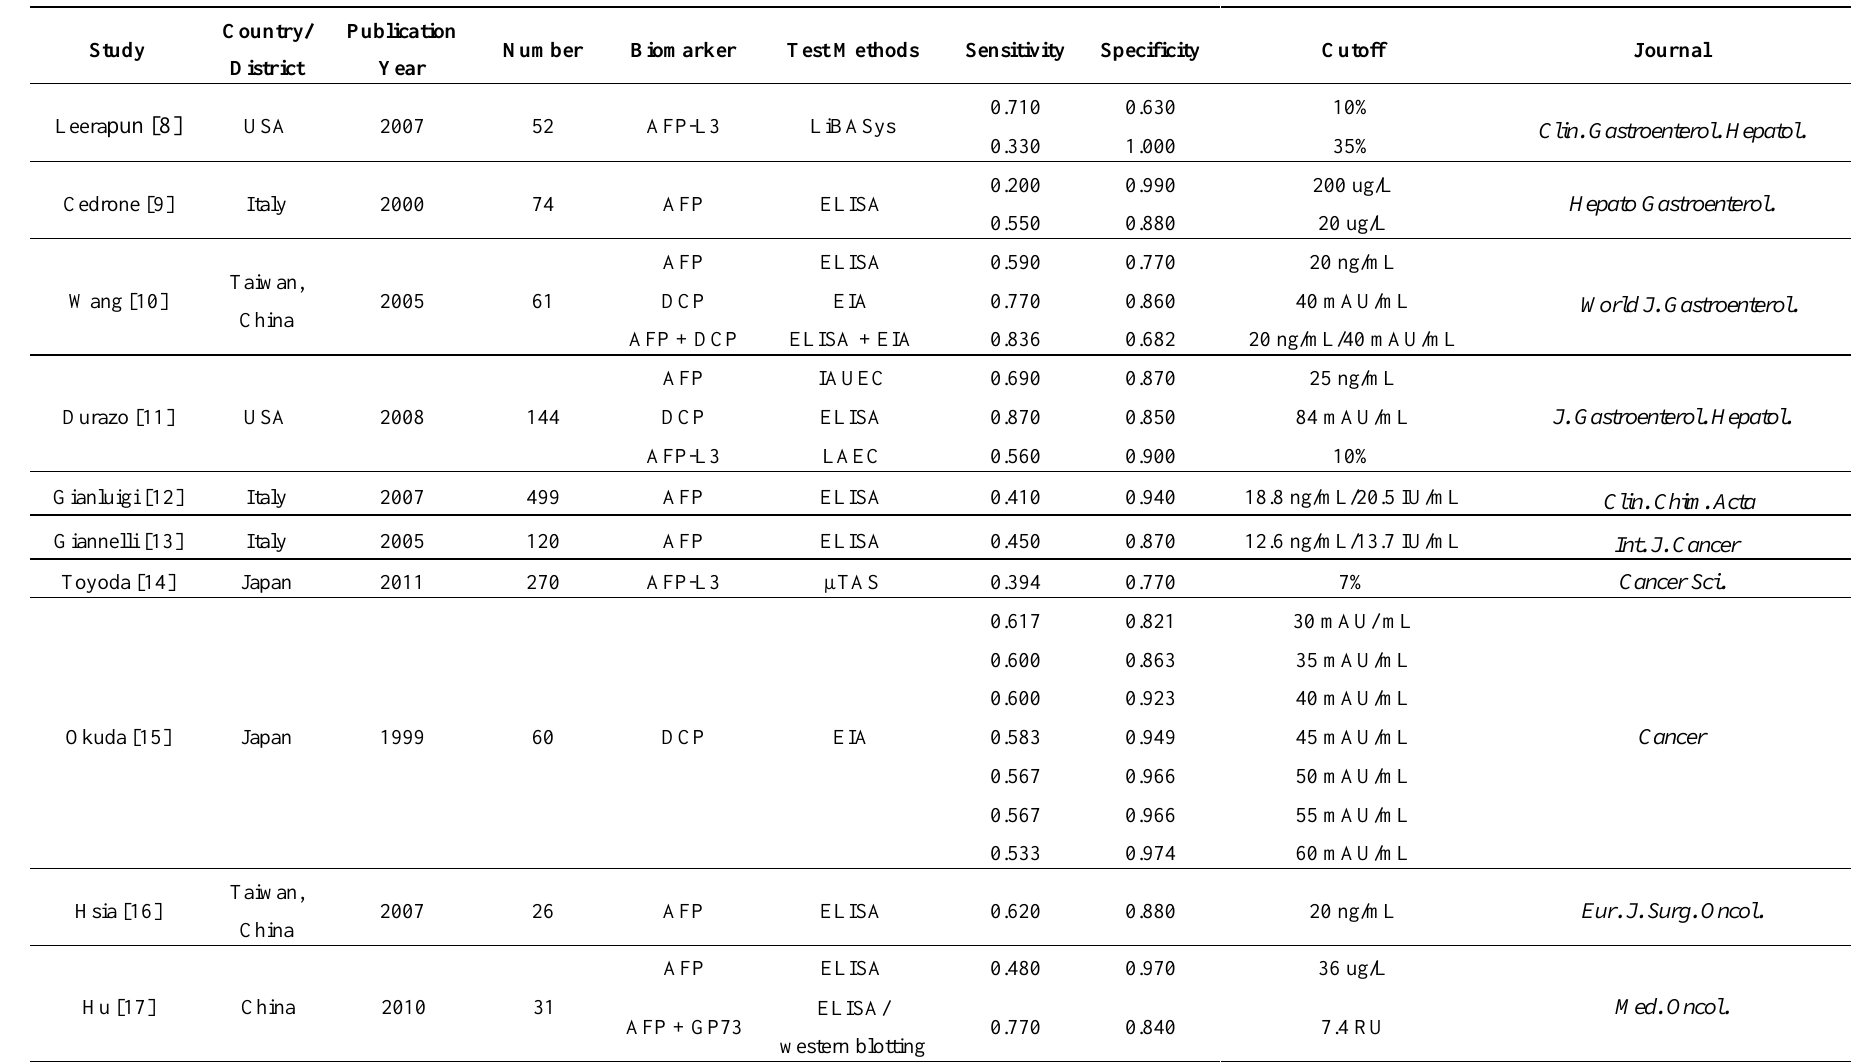
Table 2. Data from the selected